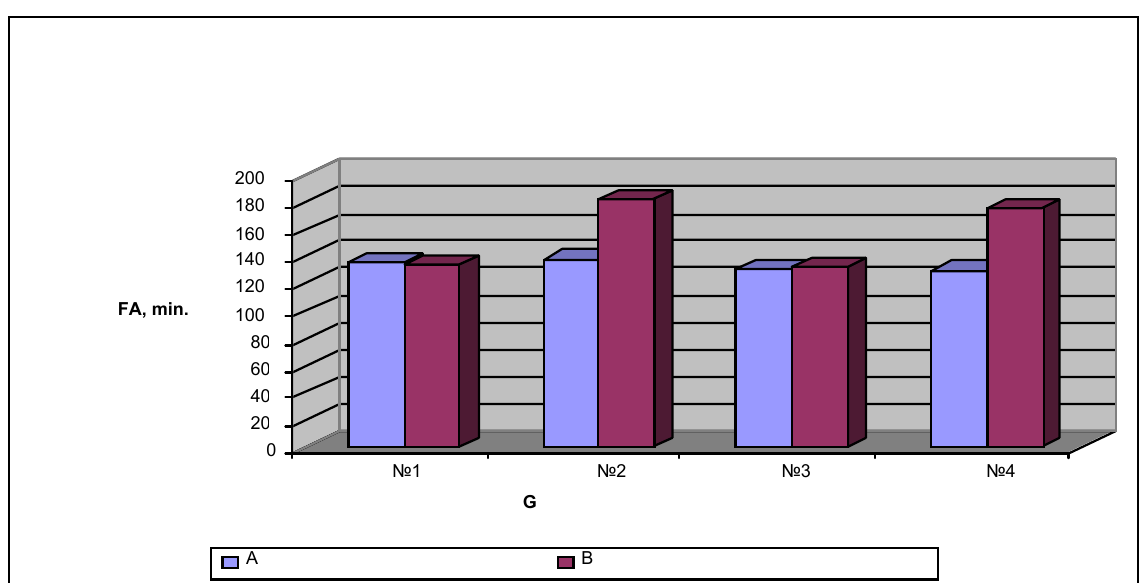
Fig. 1. Dynamics of volume changes of students physical activity per week during researches. FA – the volume of physical activity (minutes), A – the beginning of researches, B – the end of researches, G – the examined